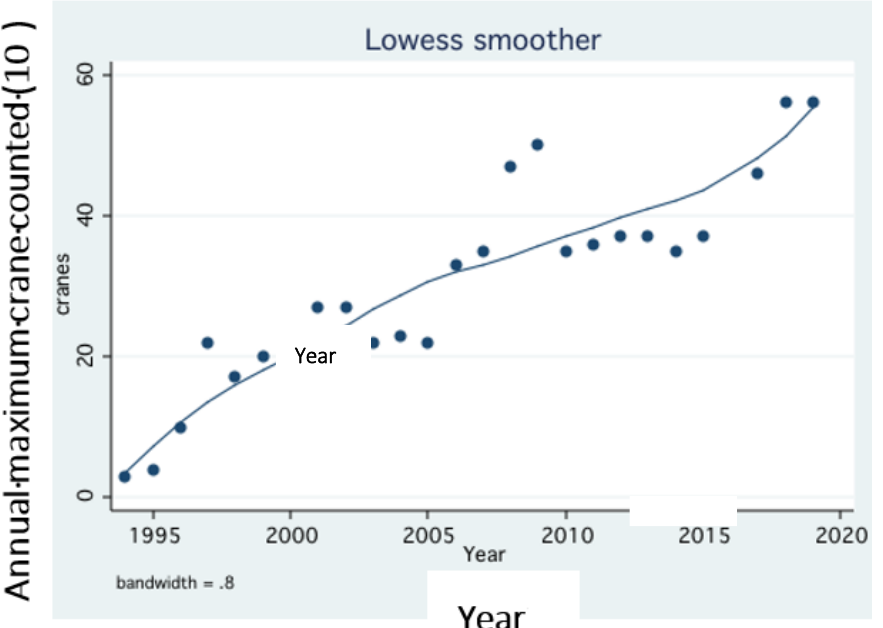
Figure 16. Temporal crane density (maximal counts) in the Hula Valley during 1995–2019: LOWESS Smoother (bandwidth 0.8).